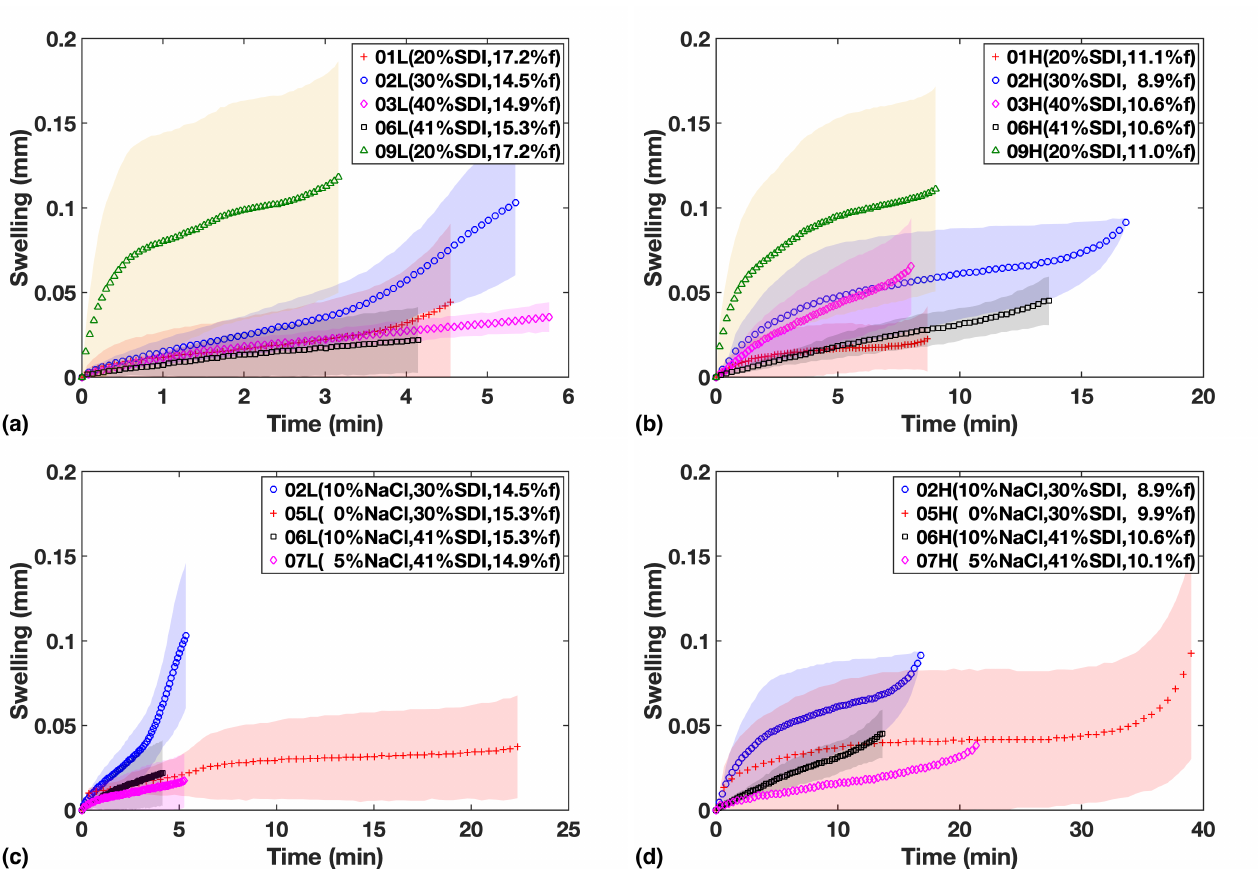
Figure 4. Swelling in mm vs. time for formulations in study 1 ( a , b ) and study 2 ( c , d ). Left column shows low compaction batches and right column shows High compaction